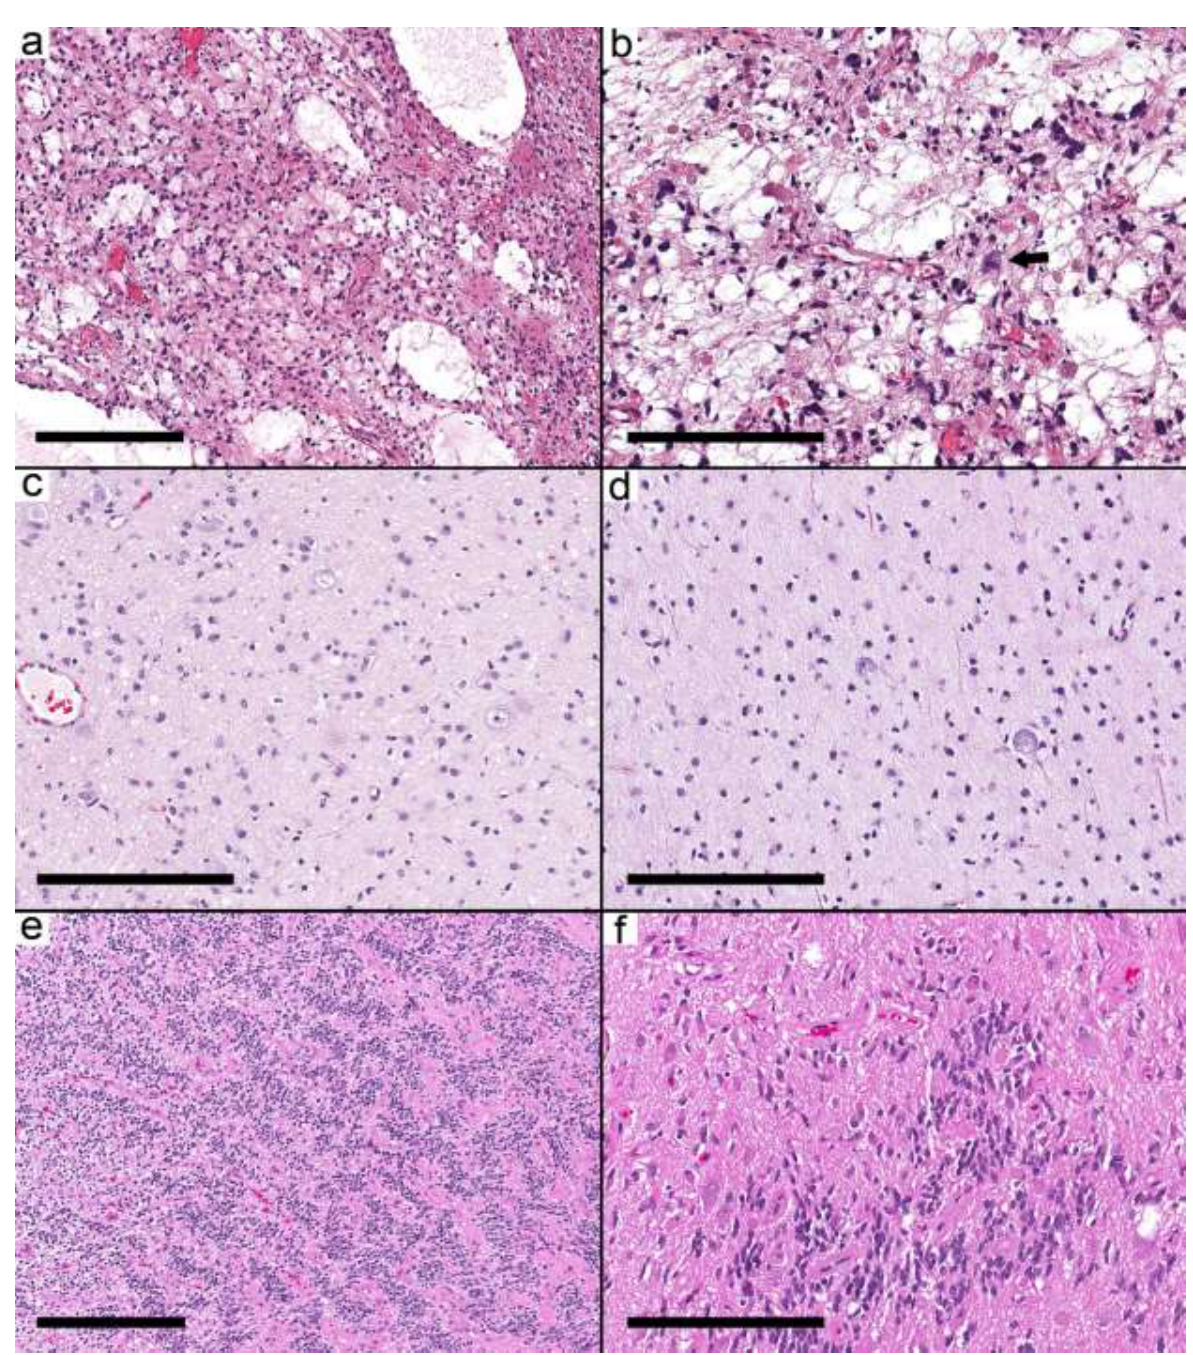
Figure 1. Integrated diagnosis is a specific entity other than ganglioglioma. ( a ) Pilocytic astrocytoma (Case 2) with a biphasic pattern. ( b ) Microcystic space with pleomorphic cells and eosinophilic granular bodies. A single dysmorphic ganglion (arrow) is present. ( c , d ) MYB-altered glioma (Case 3) with small round cells and scattered large ganglion cells. ( e ) CNS embryonal tumor (EWSR1-PLAGL1) NEC (Case 5) showing ribbons and trabecular arrangement of small primitive cells and perivascular pseudorosettes. ( f ) Areas with dysmorphic ganglion cells. Scale bars: 600 µ m ( a , e ); 200 µ m ( b – d , f